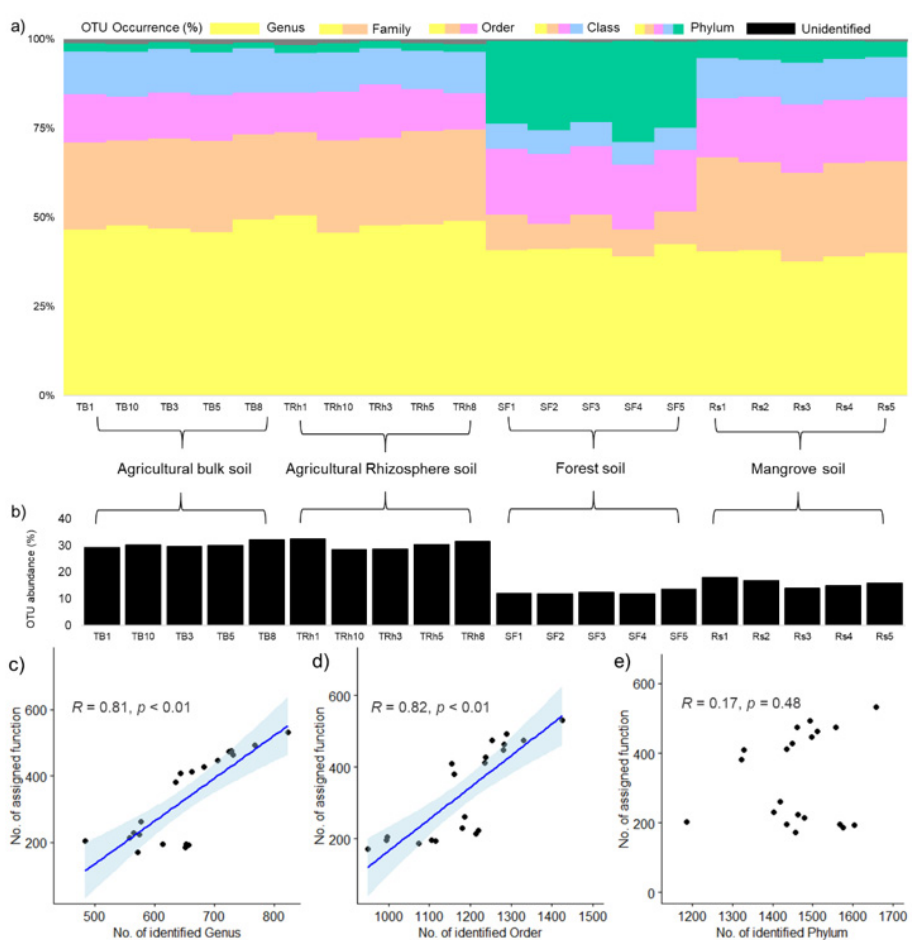
Figure 2. Taxonomic information across all soil samples and correlation between numbers of identified and functionally assigned OTUs. ( a ) Proportion of OTUs identifying to different taxonomic ranks. ( b ) Bar plot showing FAPROTAX’s